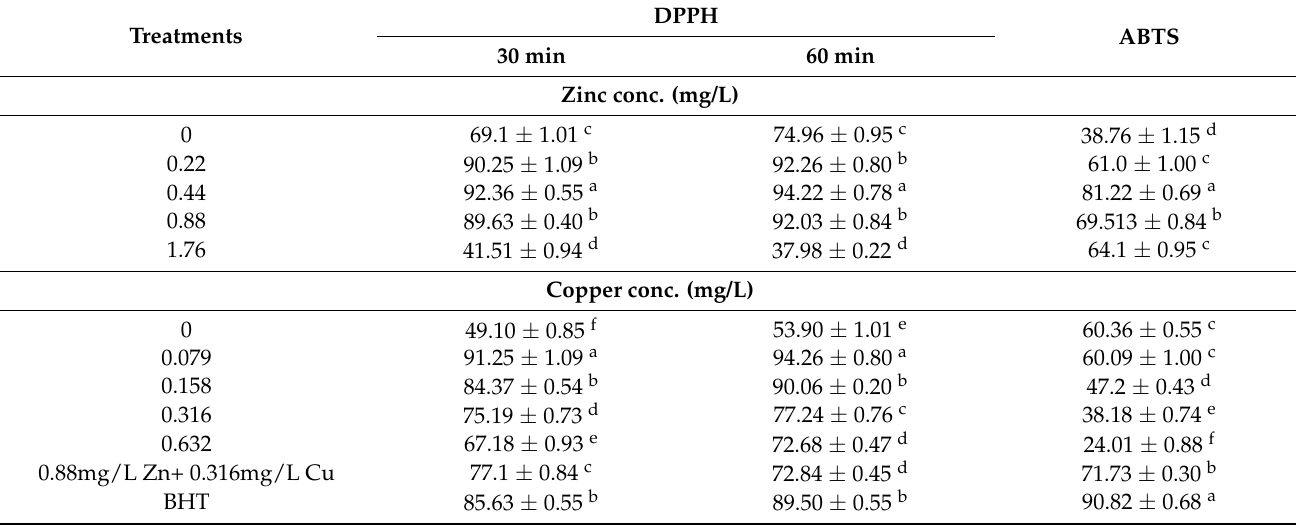
Table 8. Antioxidant activity (%) of Nostoc linckia extract grown on various zinc and copper concentration against DPPH and ABTS radical methods.